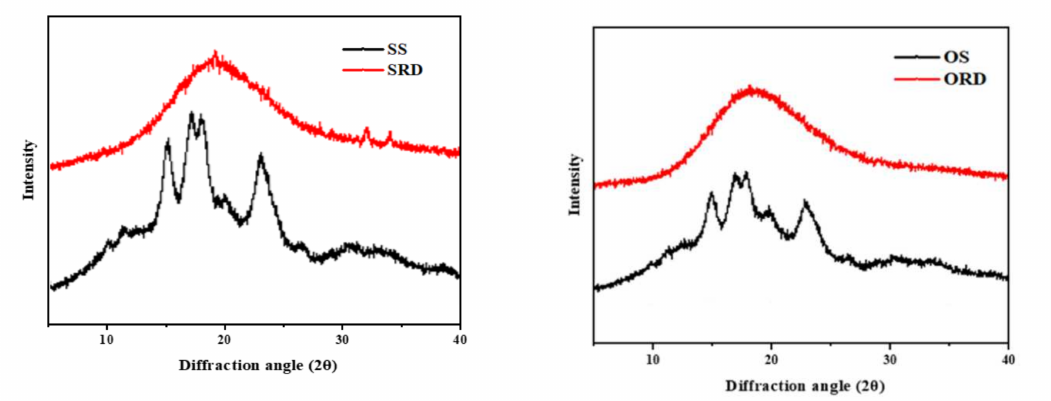
Figure 3. X-ray diffraction patterns of sorghum/oat starch and sorghum/oat resistant dextrin. SS: sorghum starch; SRD: sorghum resistant dextrin; OS: oat starch; ORD: oat resistant dextrin.